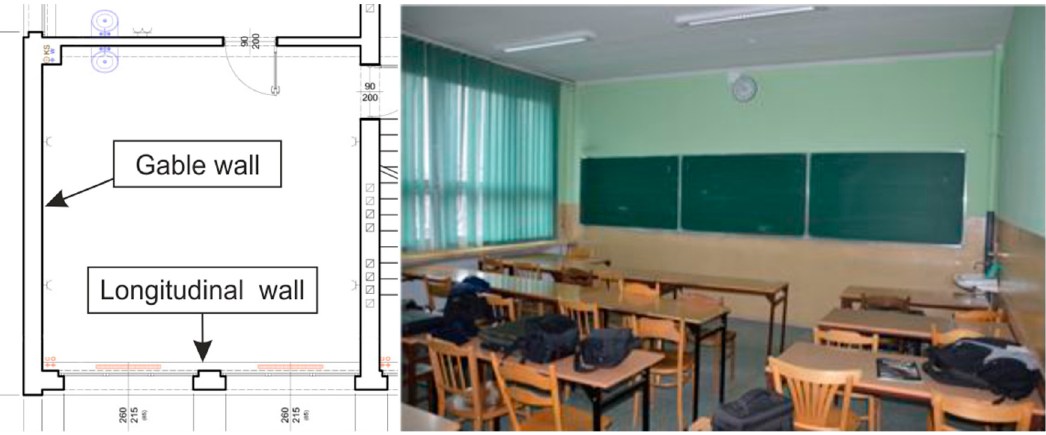
Figure 3. Projection and view of the room adjacent to the gable wall.